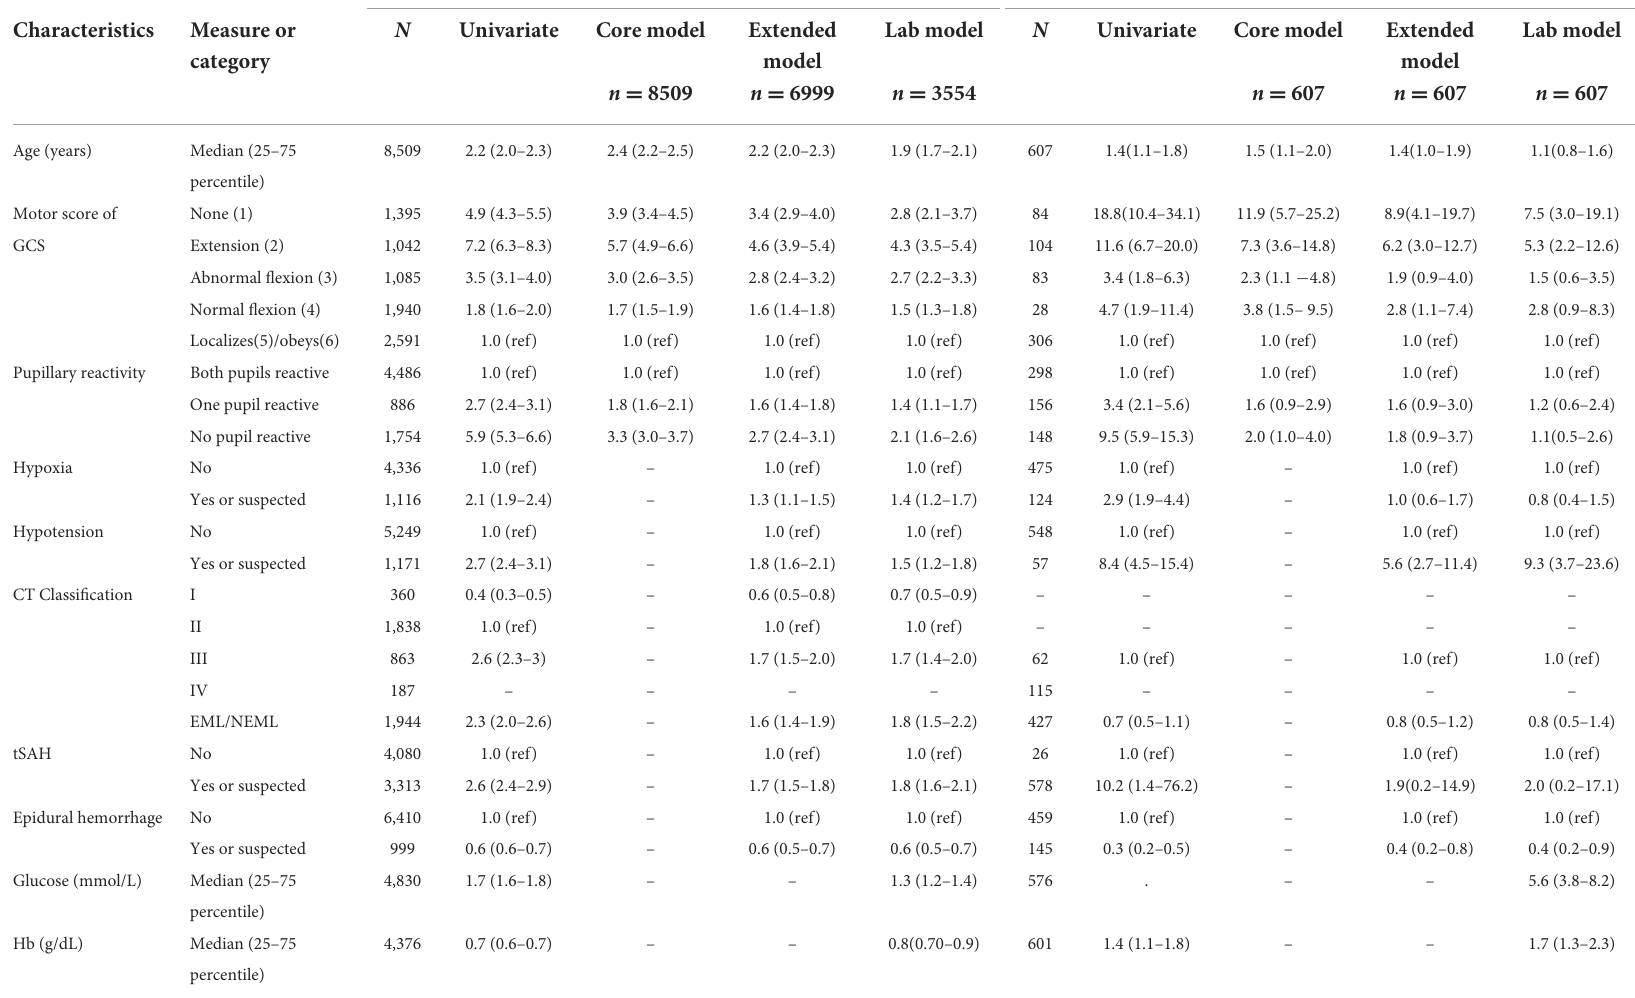
TABLE 3 Predictor effects in IMPACT ( n = 8,509) and PLANC cohorts ( n = 607) (missing values were